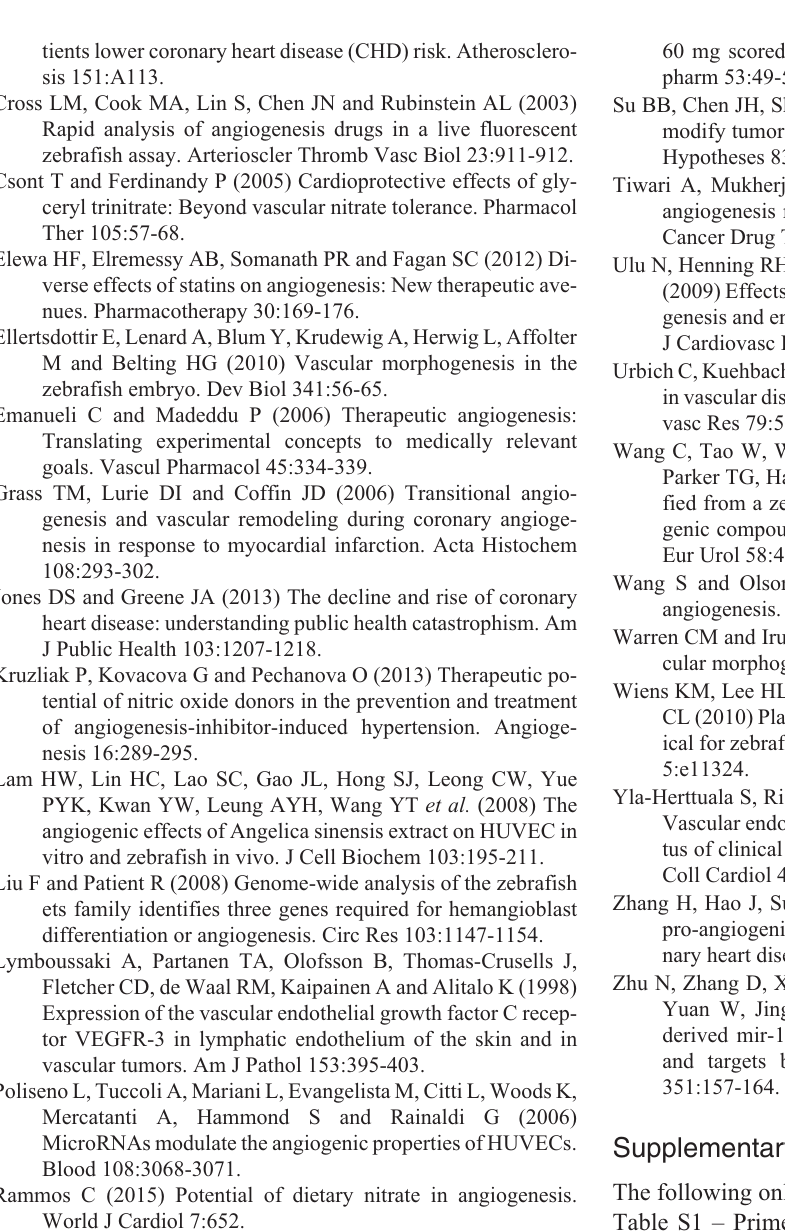
Table S1 – Primers for genes involved in angiogenesis in zebrafish. Table S2 – Primers for miRNAs involved in angiogenesis in